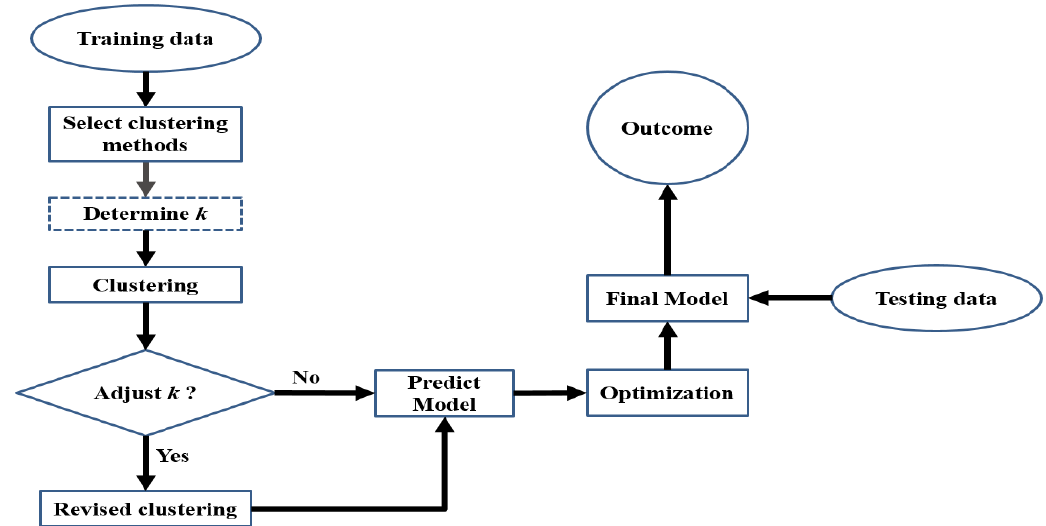
Figure 6. Flowchart of establishing prediction model. The procedure first selected a suitable clustering method according to the training data. Then, we determined the best number of cluster k, if the clustering method was needed. After obtaining the result of clustering, we drew and observed the scatterplot of clustering to determine whether to adjust k or not. Finally, we used the machine learning algorithm to train each cluster to obtain the prediction models, and optimized these models to obtain the final model.